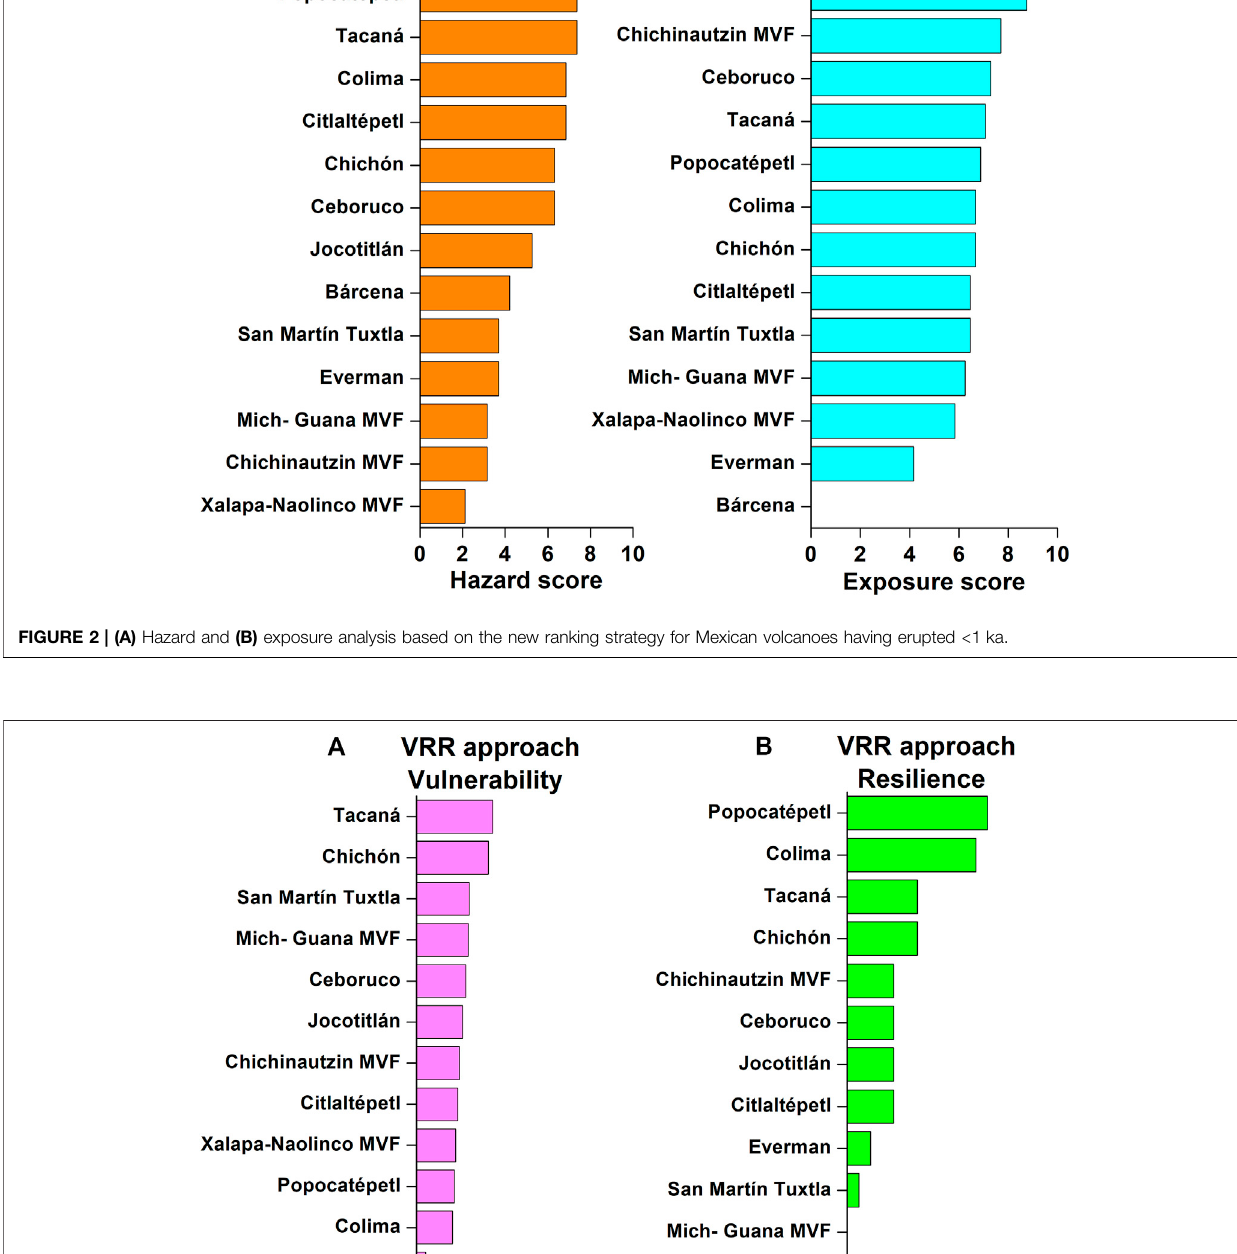
Frontiers in Earth Science |